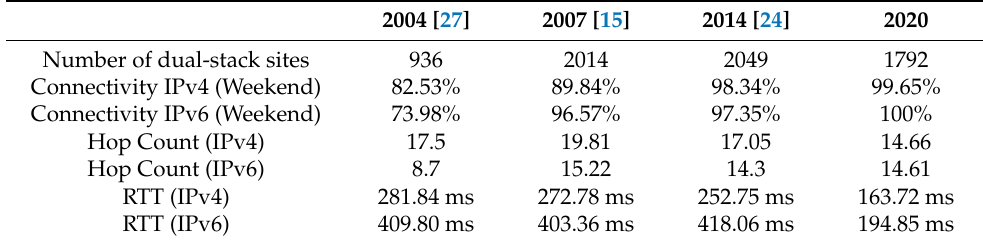
Table 9. Performance comparison with previous